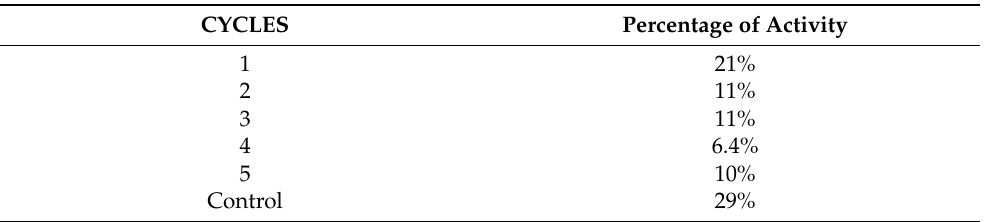
Table 4. Trypsin activity after successive synthesis cycles. Elution of high-affinity MIP nanoparticles was performed at pH 8.0. The activity was measured after 2 h at 405 nm.